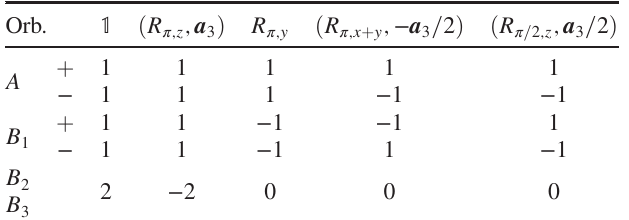
TABLE I. Character table of the irreps of the little group G for k k ¼ Γ ; M . For the first column, each row corresponds to an EBR as identified by the orbital type (i.e., the corresponding irreps of D 0 . For the remaining columns, each row 2 ) on sublattice s ¼ corresponds to a different irrep of G . For the cases in which the k same EBR gives rise to two one-dimensional irreps of G , the k wave function is either a symmetric (indicated with a þ sign in the table) or an antisymmetric ( − in the table) superposition of sublattice-polarized plane waves.